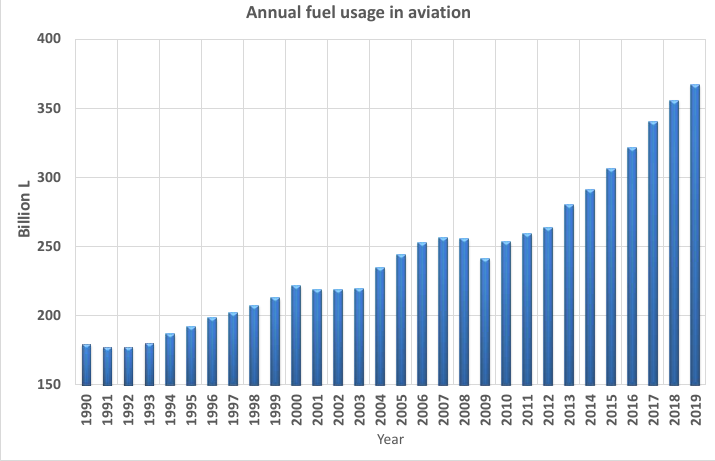
Figure 2. Annual fuel usage of Jet-A fuel (sources: Statistica, (IATA), DoE). Aerospace 2020 , 7 , x FOR PEER REVIEW